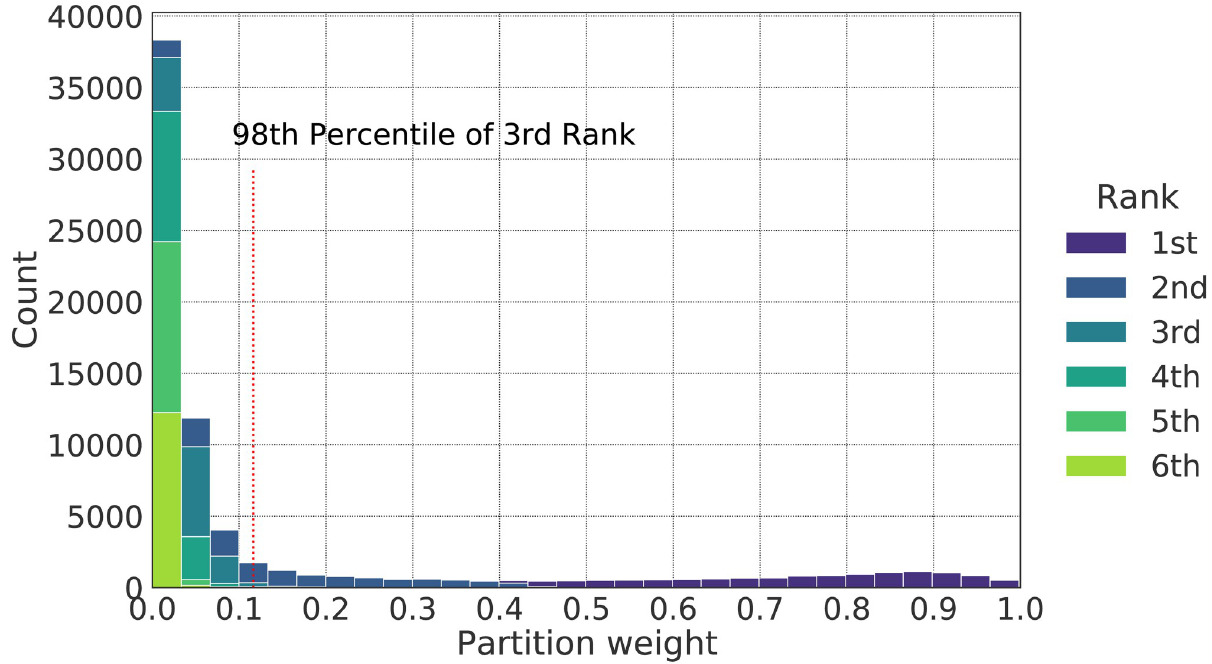
Fig 6. Distribution of FCM partition weights for m = 2. The hue indicates the rank in which the weights were given for each prediction. The dotted line shows the threshold above which 2nd ranked clusters are considered as valid secondary phenological stages.